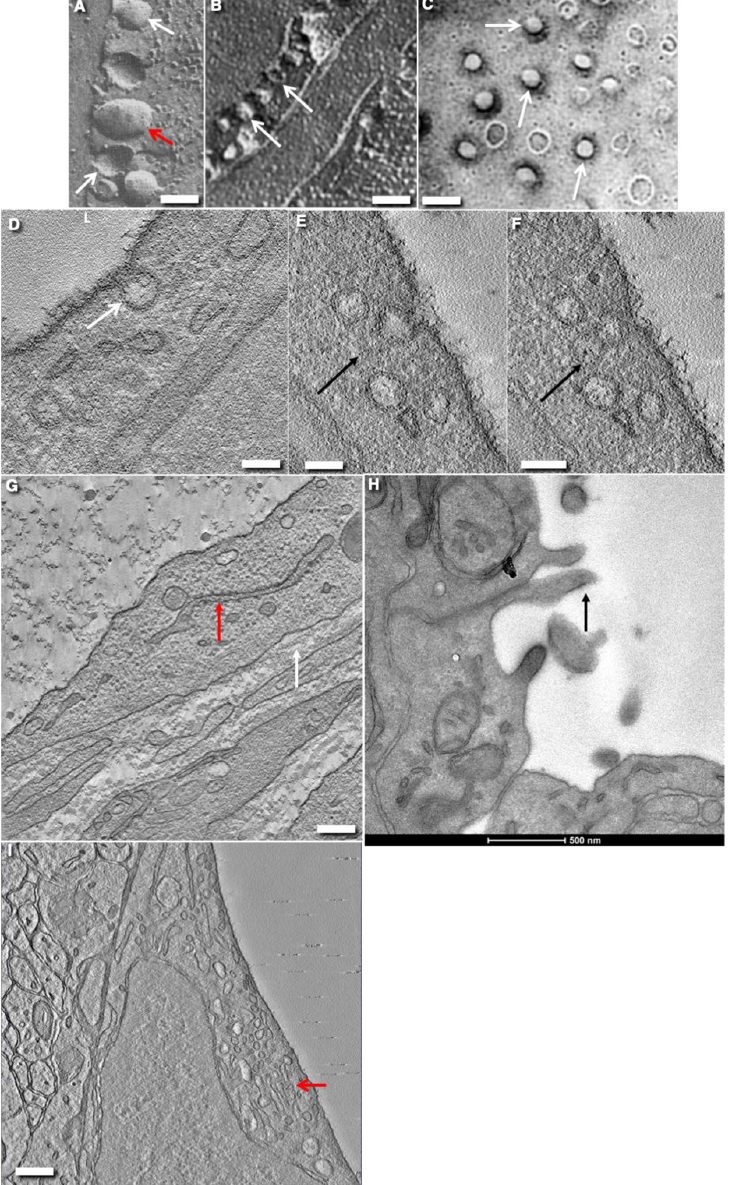
Figure 3. Structure of endothelial cells in different types vessels in rats and mice. ( A , B ) The cross- freeze-fractures of ECs in the capillary of the heart. Platinum replicas obtained after freeze-fracture and evaporation of platinum of closed multicaveolar endothelium. White arrows show fractures of